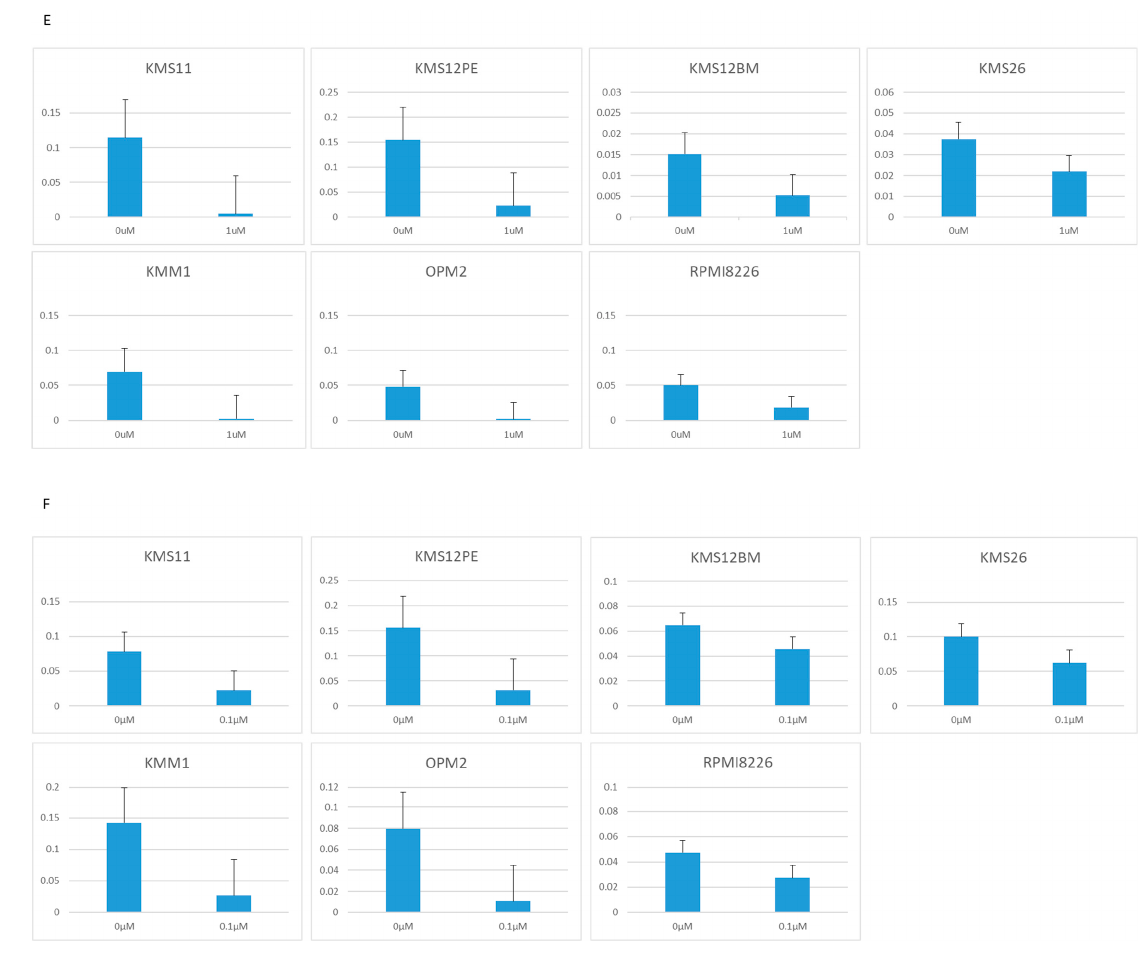
Figure 2. Growth determined using the WST-8 assay, and RNA expression determined using RQ-PCR in seven MM cell lines treated with two BRD4 inhibitors: JQ1 (0, 1, 10 μ M) and CPI-203 (0, 0.1, 1 μ M). ( A ) Cell growth under treatment with JQ1. ( B ) Cell growth under treatment with CPI-203. ( C ) PVT1 expression under treatment with JQ1. ( D ) PVT1 expression under treatment with CPI-203. ( E ) MYC expression under treatment with JQ1. ( F ) MYC expression under treatment with CPI-203.